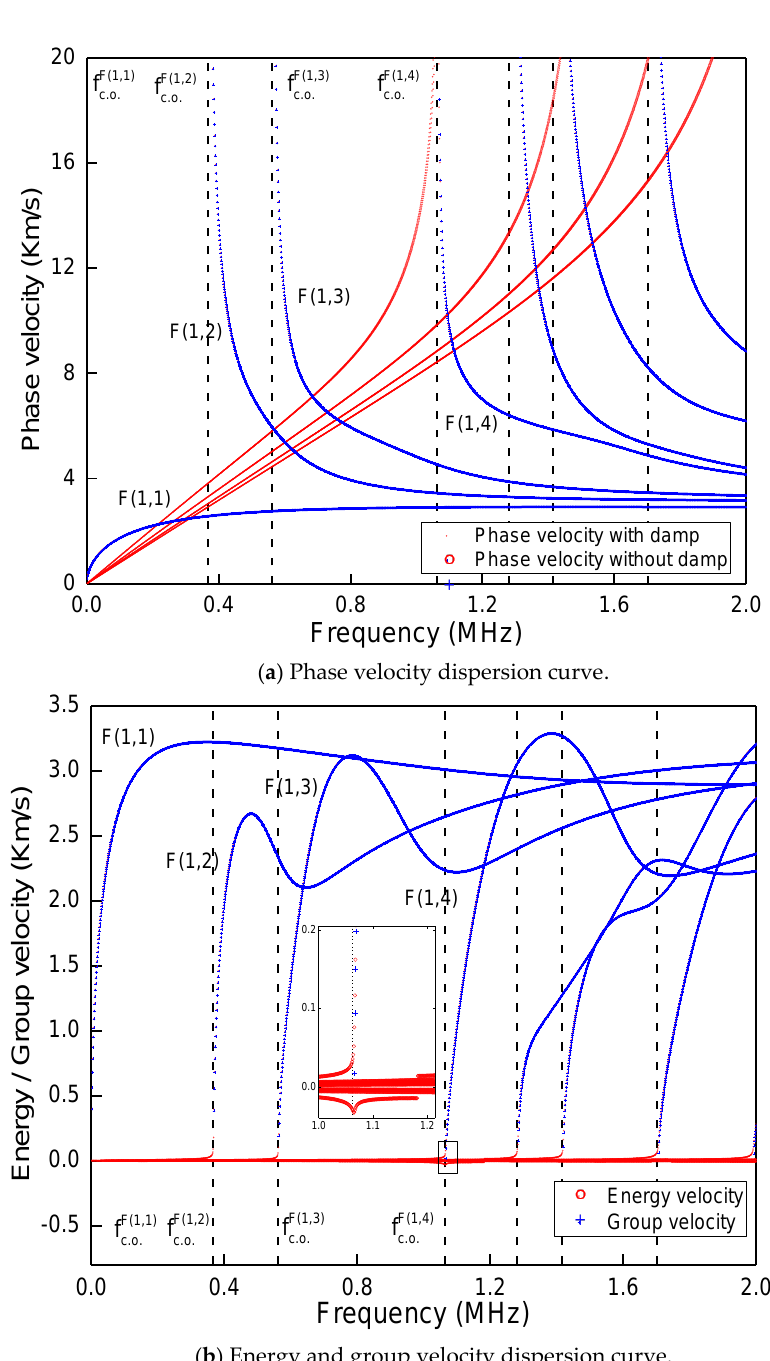
Figure 12. Low-order bending wave mode: ( a ) Phase velocity dispersion curve; ( b ) Energy/group velocity dispersion curve.